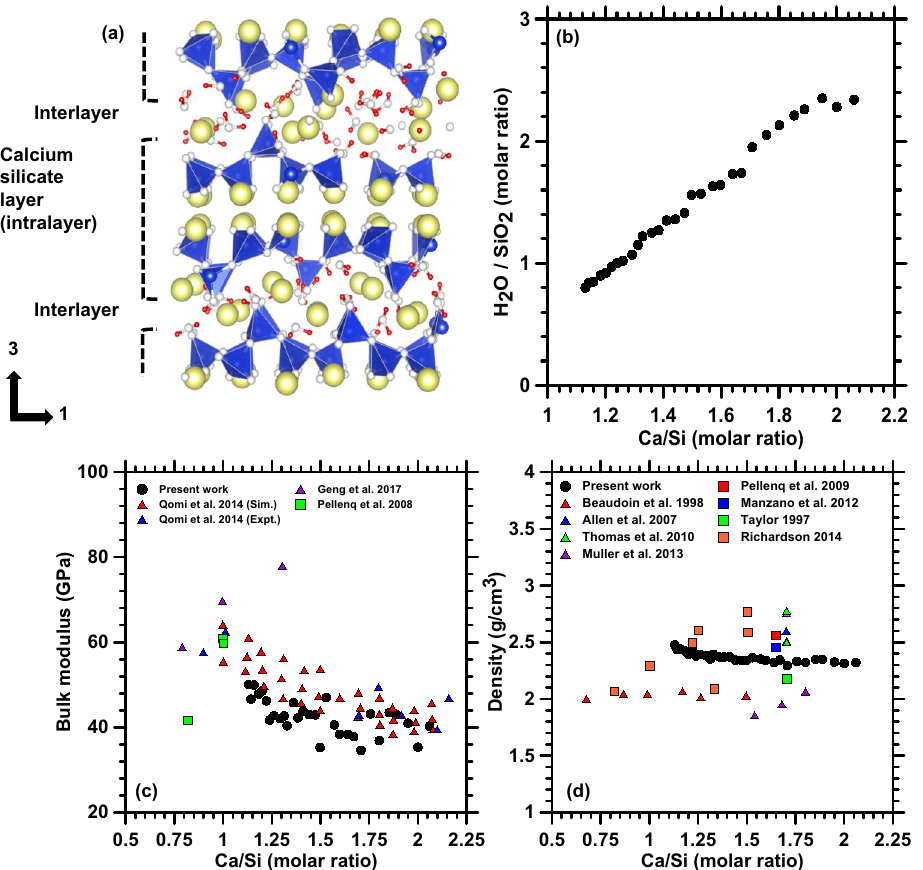
Figure 1. ( a ) Representative C–S–H structure for Ca/Si = 1.09 showing the Calcium silicate network and the interlayer spaces, and ( b ) water content (H 2 O/SiO 2 molar ratio) as a function of Ca/Si molar ratio for representative C–S–H structures with saturation water content, ( c ) The bulk modulus, and ( d ) density as a function of Ca/Si molar ratio for representative C–S–H structures with saturation water